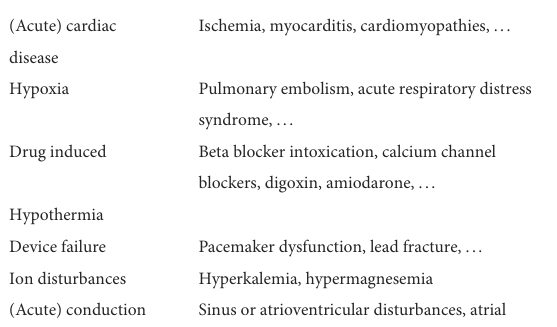
TABLE 1 Etiologies of bradycardia- and tachycardia-induced cardiogenic shock. Bradycardia induced cardiogenicshock (sinus-, idioventricular-,escape rhythm, ...) (Acute) cardiac Ischemia, myocarditis, cardiomyopathies, ... disease